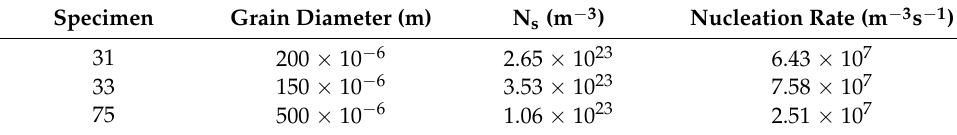
Table 7. Nominal nucleation rates and number of nucleation